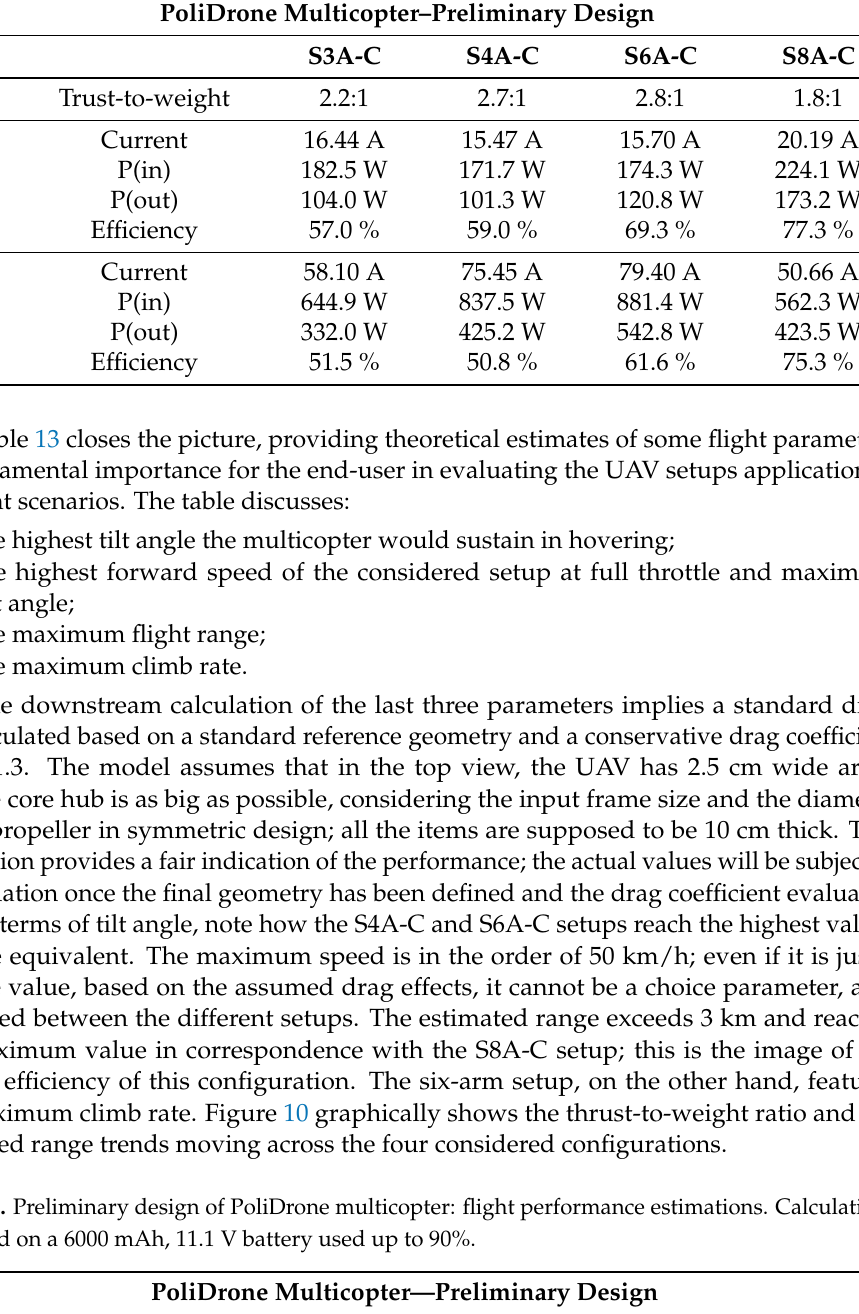
Table 12. Preliminary design of PoliDrone multicopter: motors performance estimations. Calculations are based on a 6000 mAh, 11.1 V battery used up to 90%.